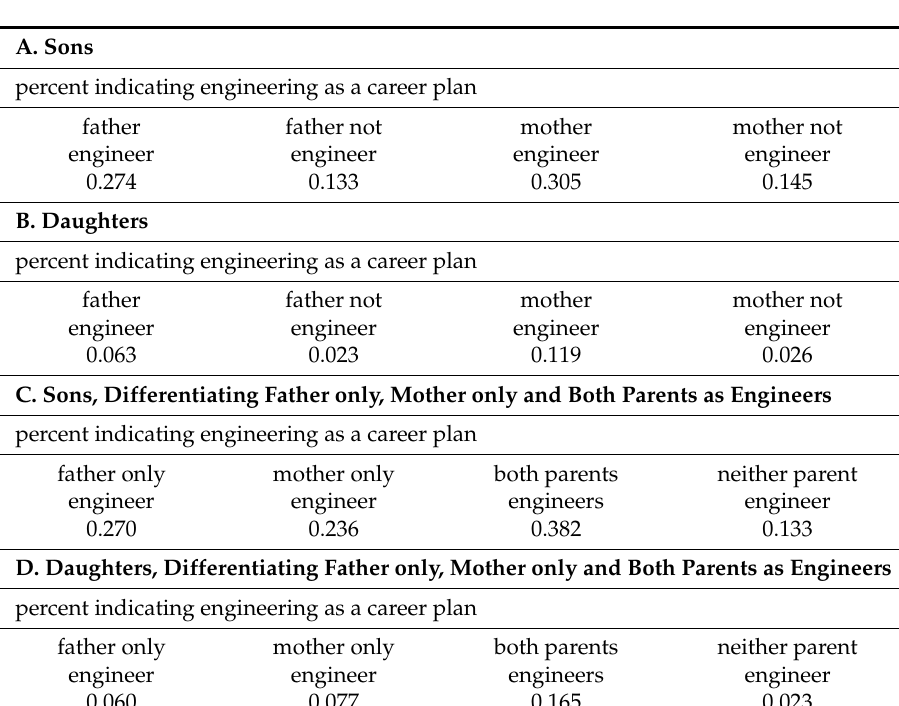
Table 1. Interest in Engineering by Parental Engineering Employment and